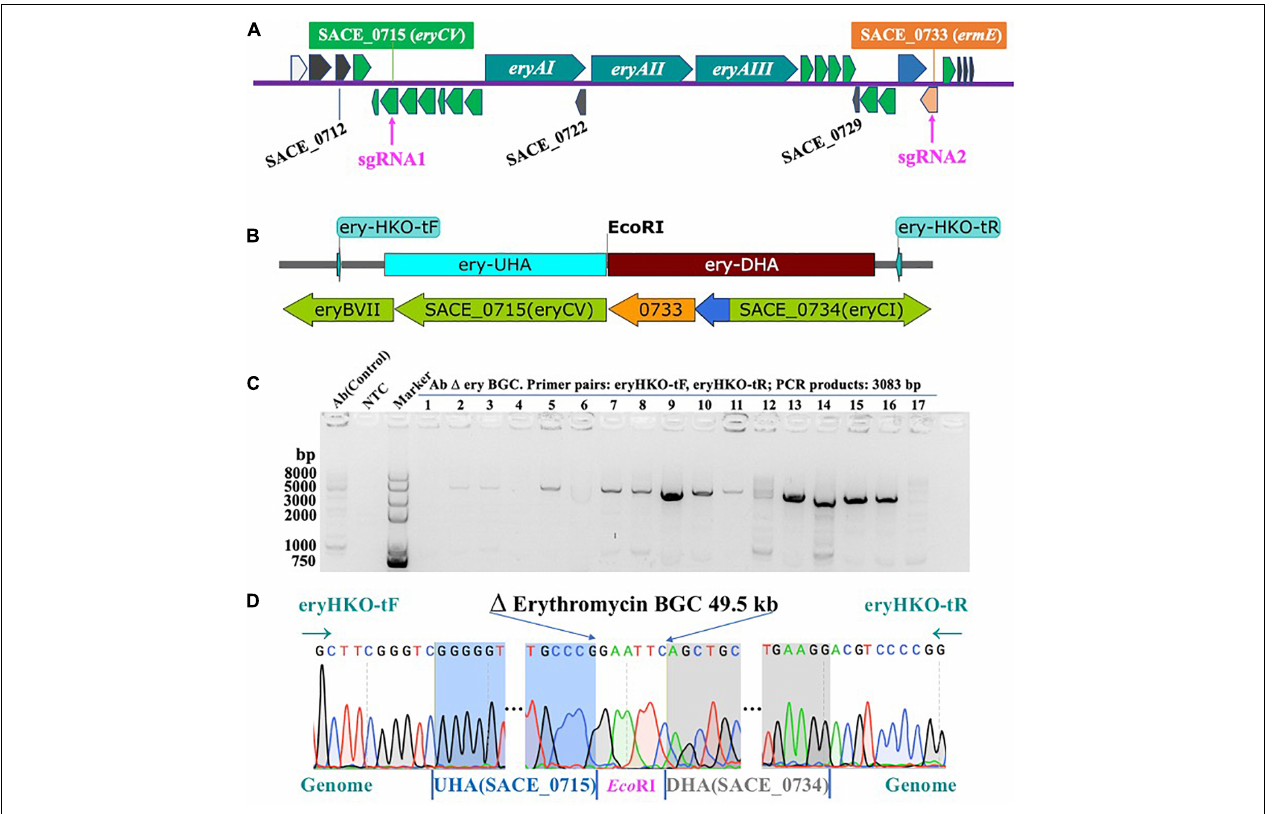
FIGURE 2 | Knock-out of erythromycin biosynthetic gene cluster. (A) Erythromycin Biosynthetic Gene cluster (from SACE_0713 to SACE_0734) and the target of sgRNAs (SACE_0715 and SACE_0733). (B) Schematic of knock-out Erythromycin biosynthetic gene cluster. (C) Agarose gel electrophoresis of PCR products from Ab (cid:49) ery using test primer pairs (eryHKO-tF, eryHKO-tR). The size of PCR products is 3083 bp. (D) Sequencing of Ab (cid:49) ery BGC recombinant strain. 49491 bp sequence in ery BGC is knocked out.